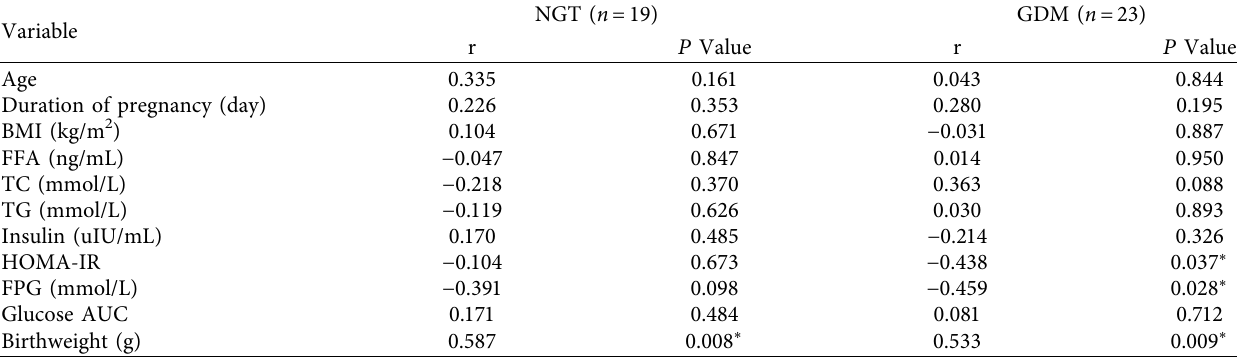
Table 3: Correlation analysis results between cord blood serum ANGPTL8 and parameters of pregnant subjects with normal glucose tolerance (NGT) and with diabetes mellitus